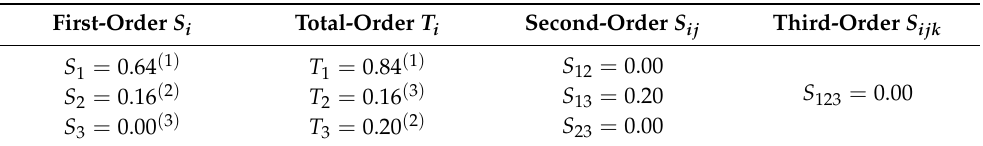
Table 2. Values of the Sobol indices for the toy example, from which the validity of Equation (21) can be easily verified, i.e., S 1 + S 2 + S 3 + S 12 + S 13 + S 23 + S 123 = 1. The inputs’ ranking according to S i and T i is reported in